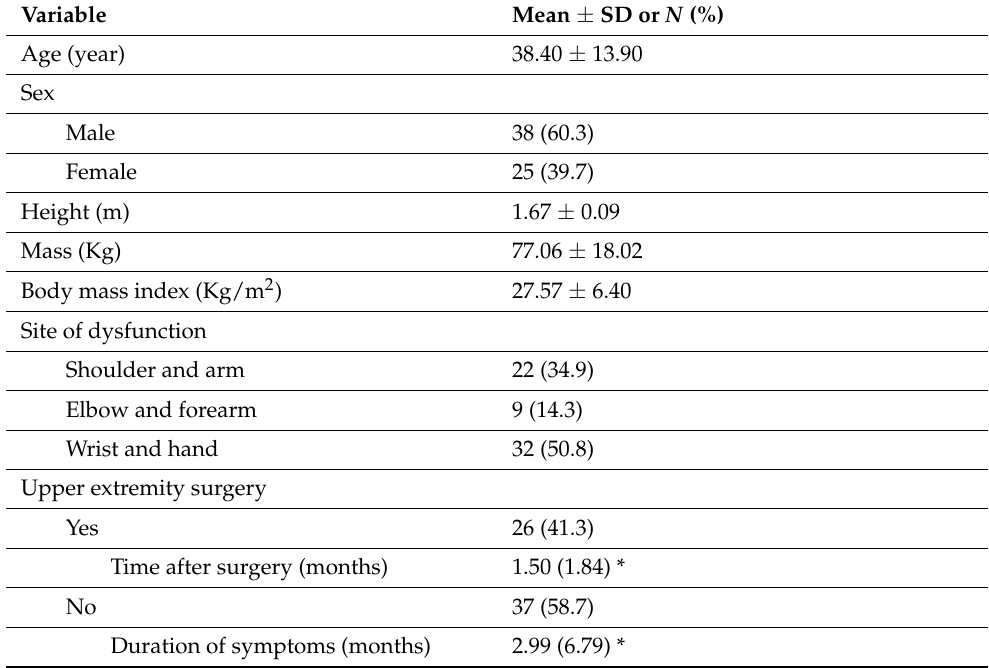
Table 1. Characteristics of participants ( N =